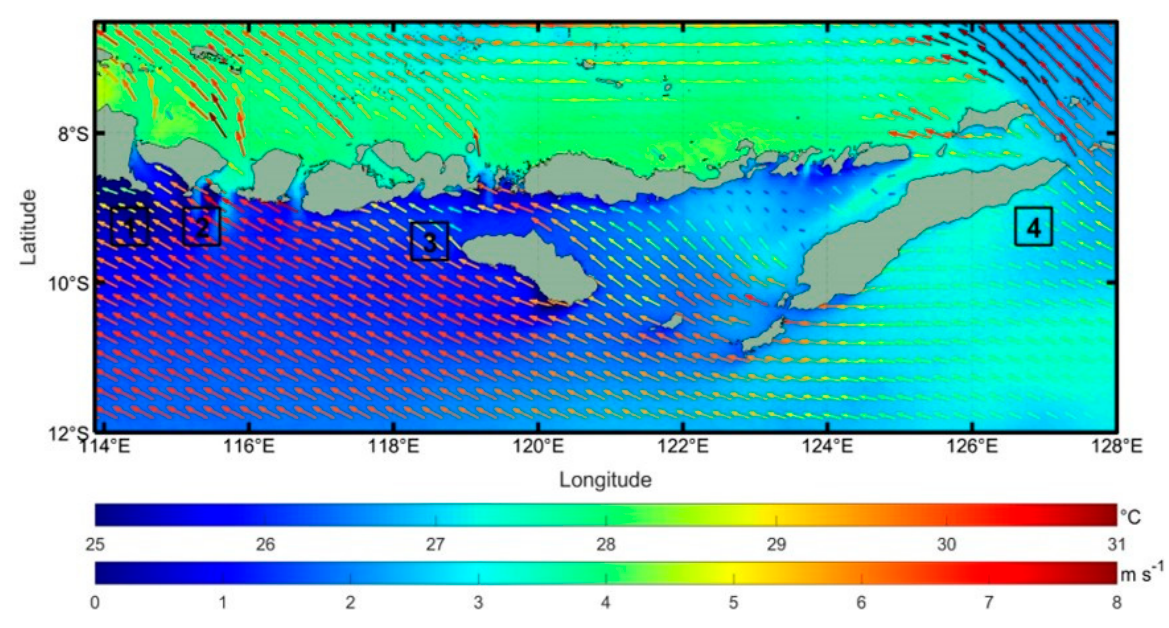
Figure 6. The climatological monthly mean values of sea surface wind and sea surface temperature (SST) in August (2007–2020). Shaded portions represent SST. Wind speed is indicated by the length of the arrow and its color.